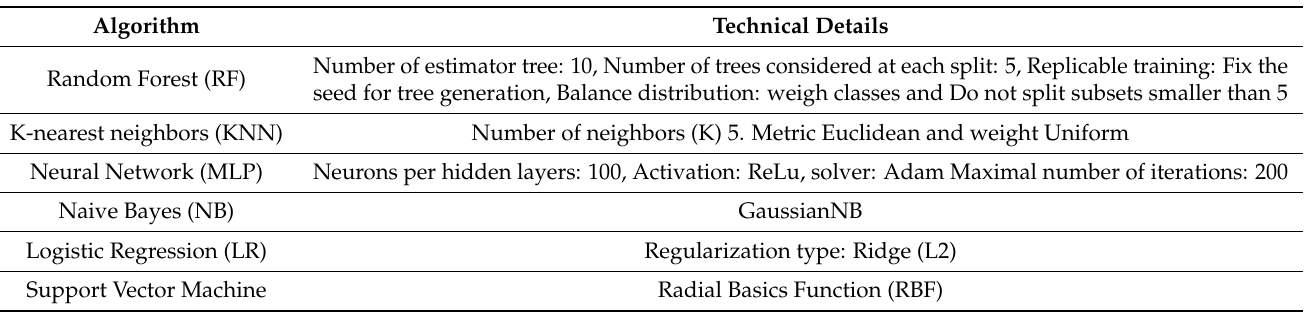
Table 3. ML Model Technical